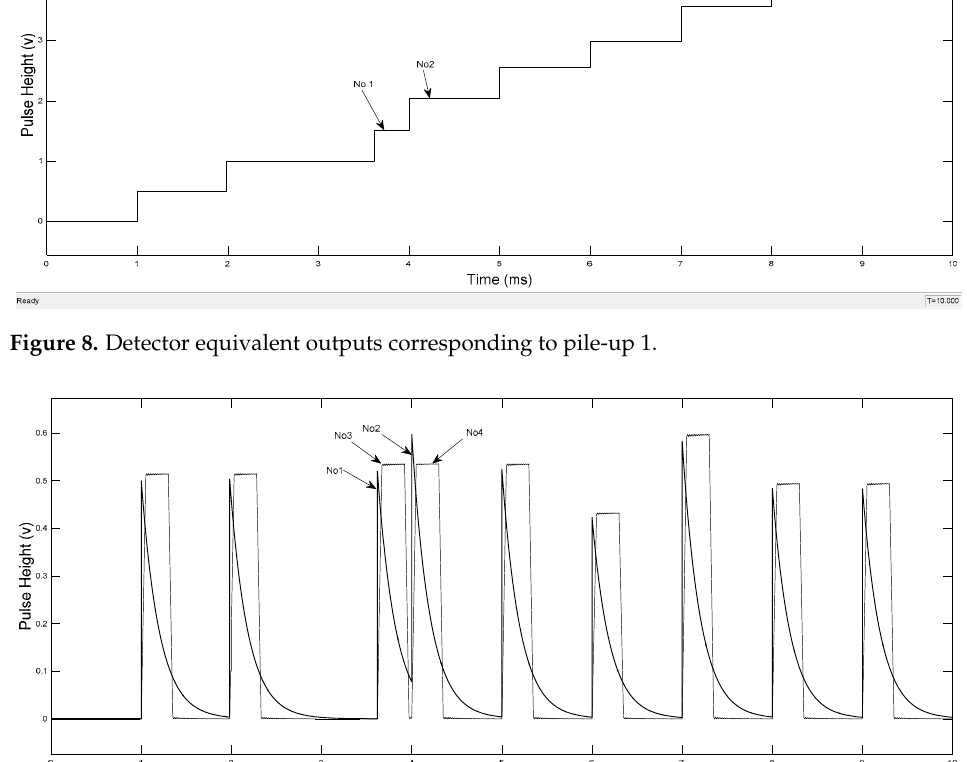
Figure 9. Pile-up 1 using the TPS algorithm.